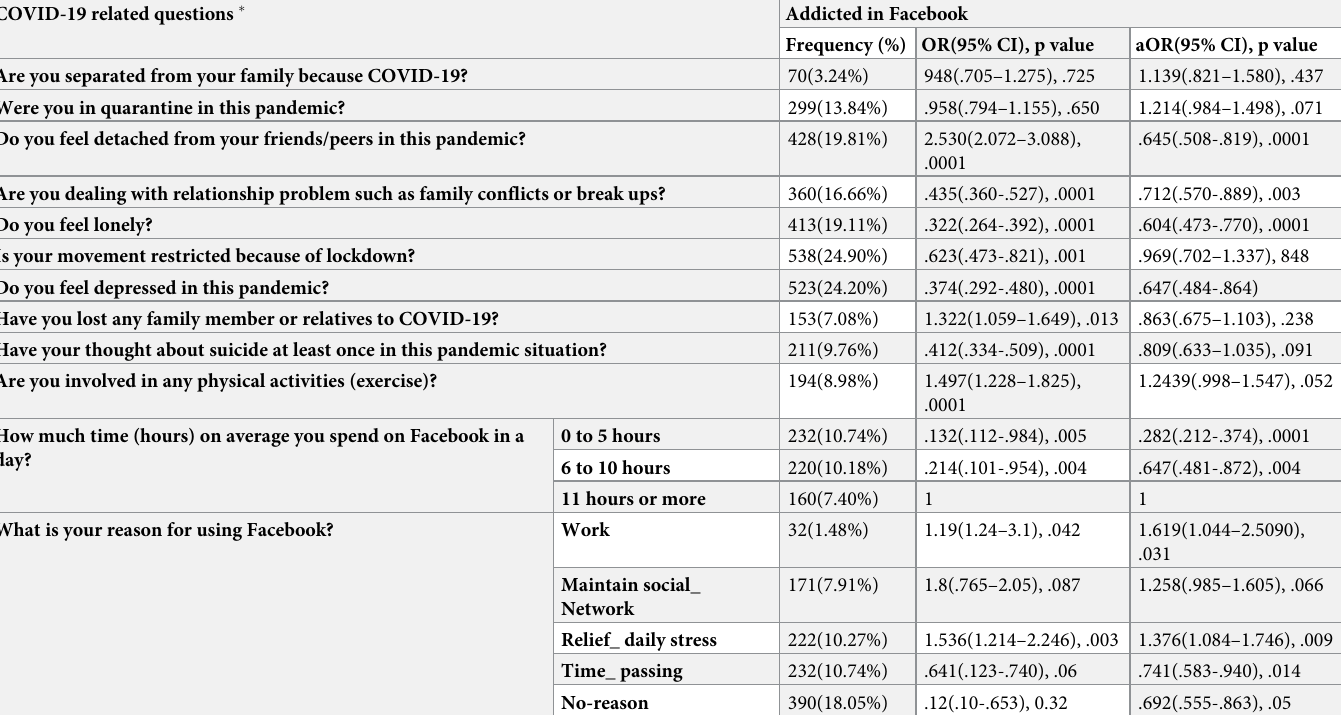
Table 3. Association of the COVID-19 related question and positive respond with addicted in